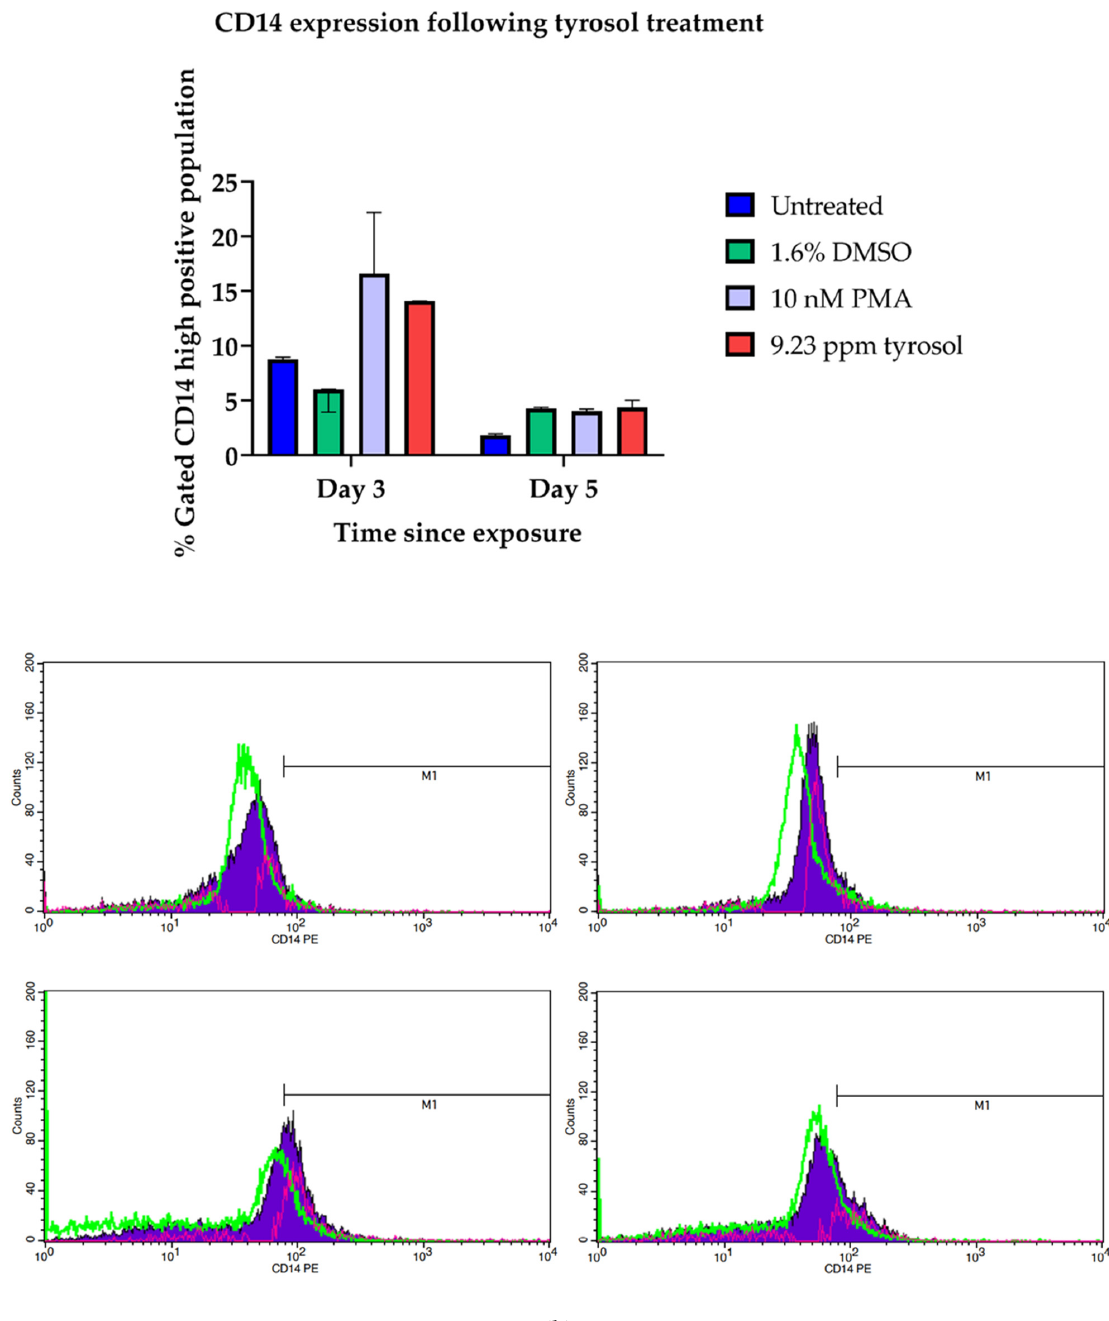
Figure 5. ( a ): A graph representing the % Gated CD11b high population on days 3 and 5 and representative histogram overlays and subtractions for each condition on day 3. Histograms from left to right = Untreated, 1.6% DMSO, 10 nM PMA, and 9.23 ppm tyrosol. Untreated = negative (medium only) control; 1.6% DMSO = granulocytic positive control; 10 nM PMA = monocytic positive control. Each bar represents the median value where n = 3 per condition. Error bars represent differences between the median and upper and lower quartiles. Statistically significant differences from the negative control are denoted by (**) p < 0.01. ( b ): A graph representing the % Gated CD14 high population on days 3 and 5 and representative histogram overlays and subtractions for each condition on day 3. Histograms from left to right = Untreated, 1.6% DMSO, 10 nM PMA, and 9.23 ppm tyrosol. Untreated = negative (medium only) control; 1.6% DMSO = granulocytic positive control; 10 nM PMA = monocytic positive control. Each bar represents the median value where n = 3 per condition. Error bars represent differences between the median and upper and lower